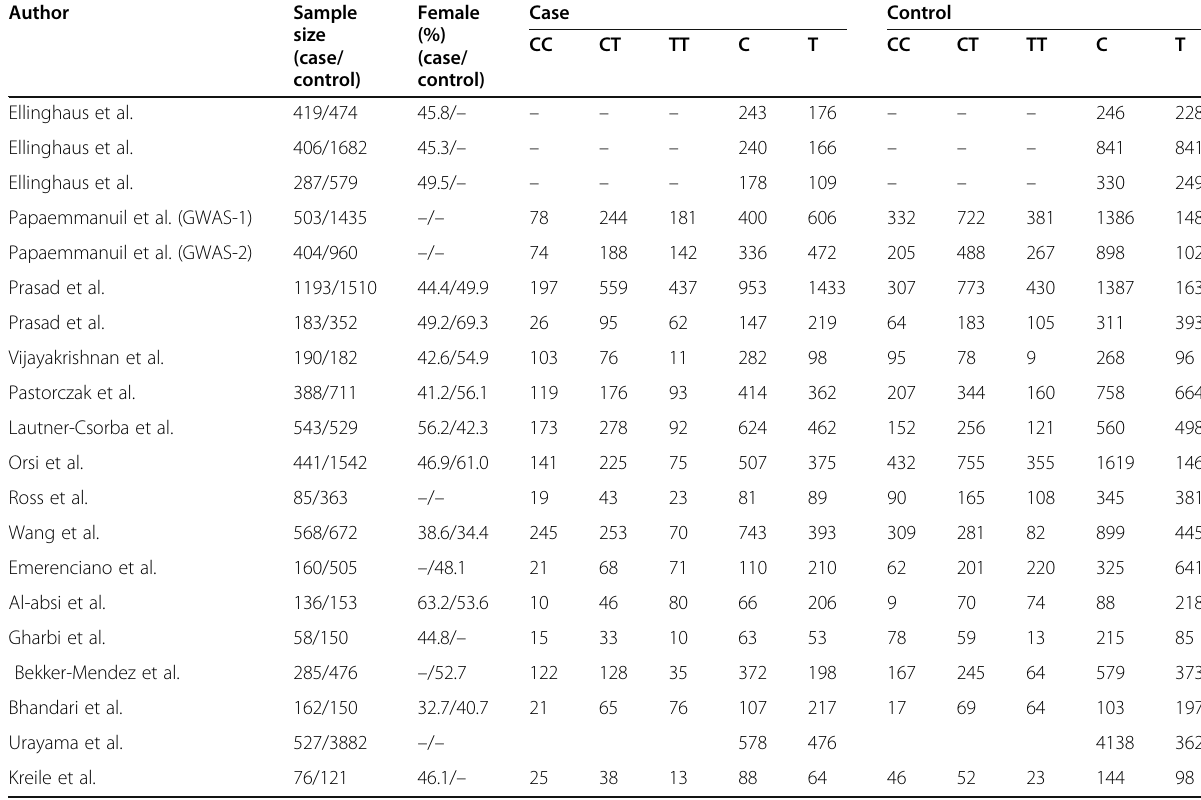
Table 2 The genotype distribution of CEBPE